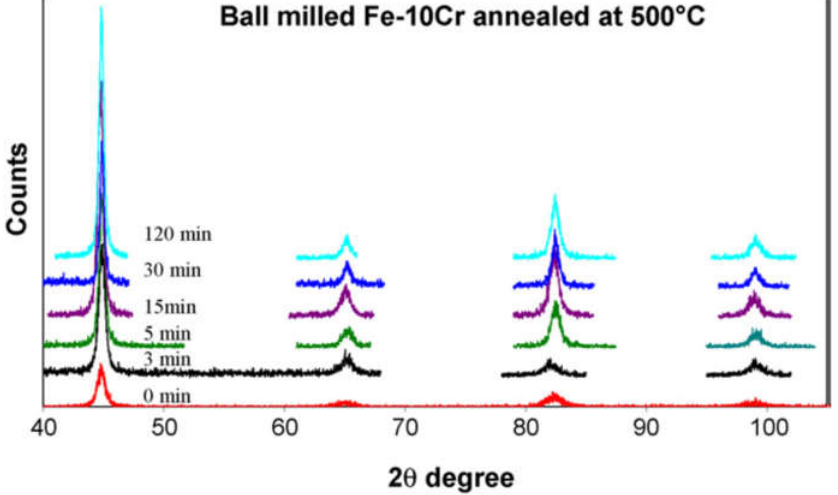
Figure 2. XRD spectra for mechanically alloyed Fe-10Cr alloy annealed for different durations (0–120 min) at 500 °C ([24], reproduced with copyright clearance).